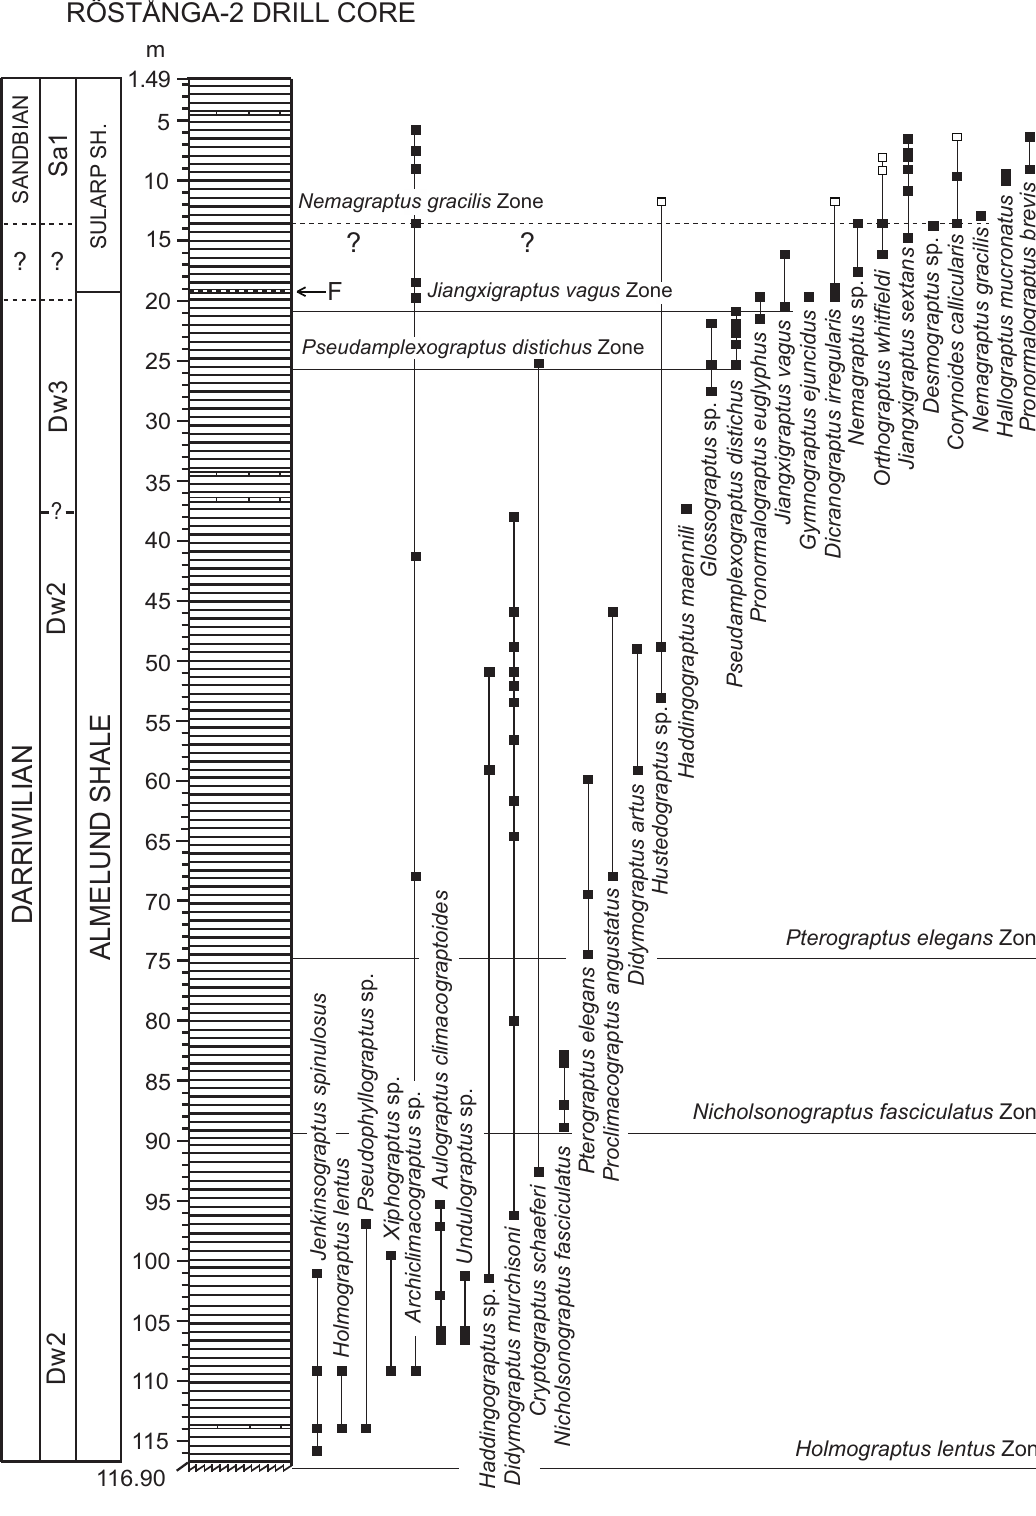
Fig. 2. Lithological succession, formation classification and graptolite species ranges through the Darriwilian–lower Sandbian succession in the Röstånga­2 drill core. Note the presence of the Fågelsång Phosphorite bed (F) just above the 20­m level. Stage slices (Dw2, Dw3, Sa1) from Bergström et al. (2009). Biostratigraphy and ranges of graptolites based on Maletz et al. (2020, fig.